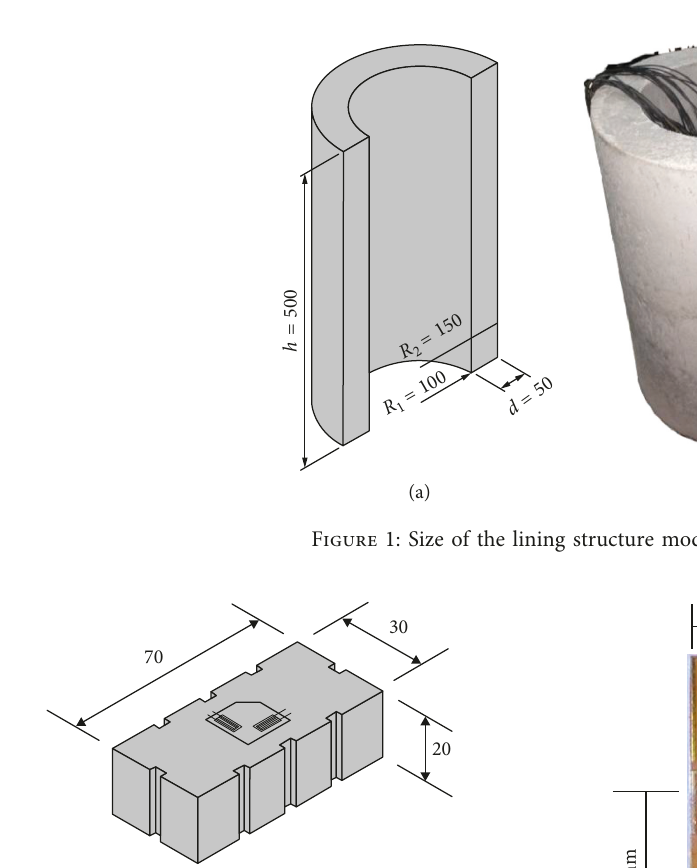
Figure 2: Size of the mortar brick (unit: mm).